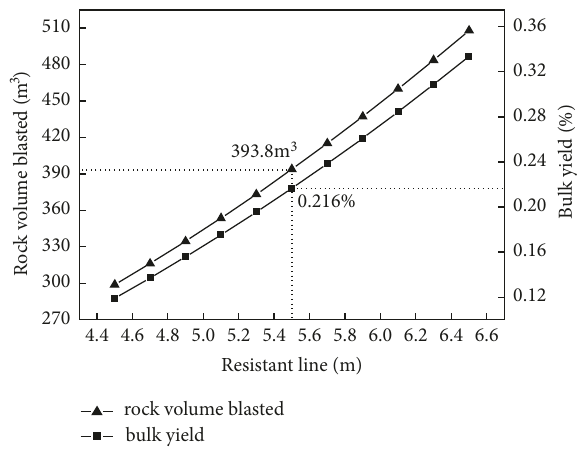
Figure 17: Curves of the resistance line, blasting volume, and bulk yield (hole spacing a =8 m).